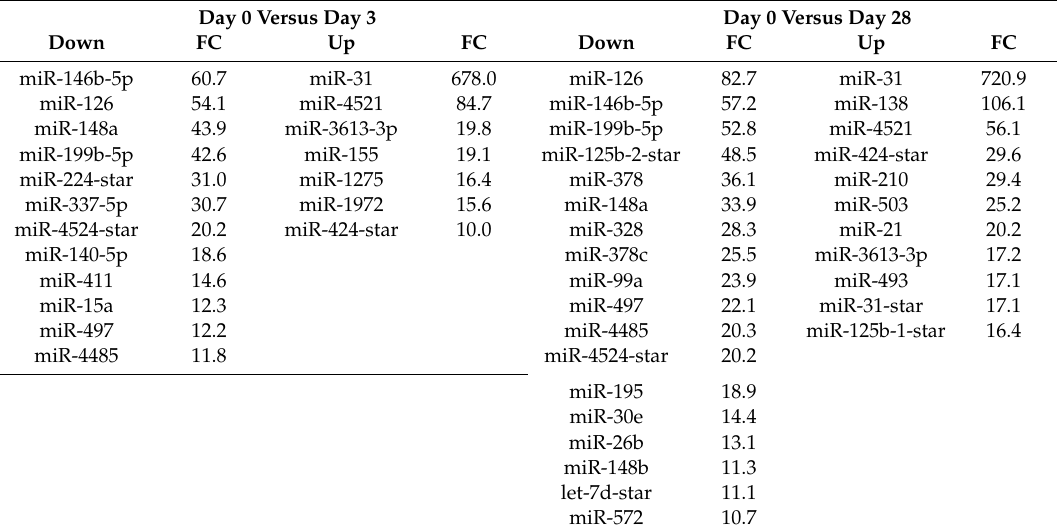
Table 1. There are significant changes in the expression of microRNAs when ex vivo adipose tissue-derived mesenchymal stromal cells (ASC) are subjected to standard tissue